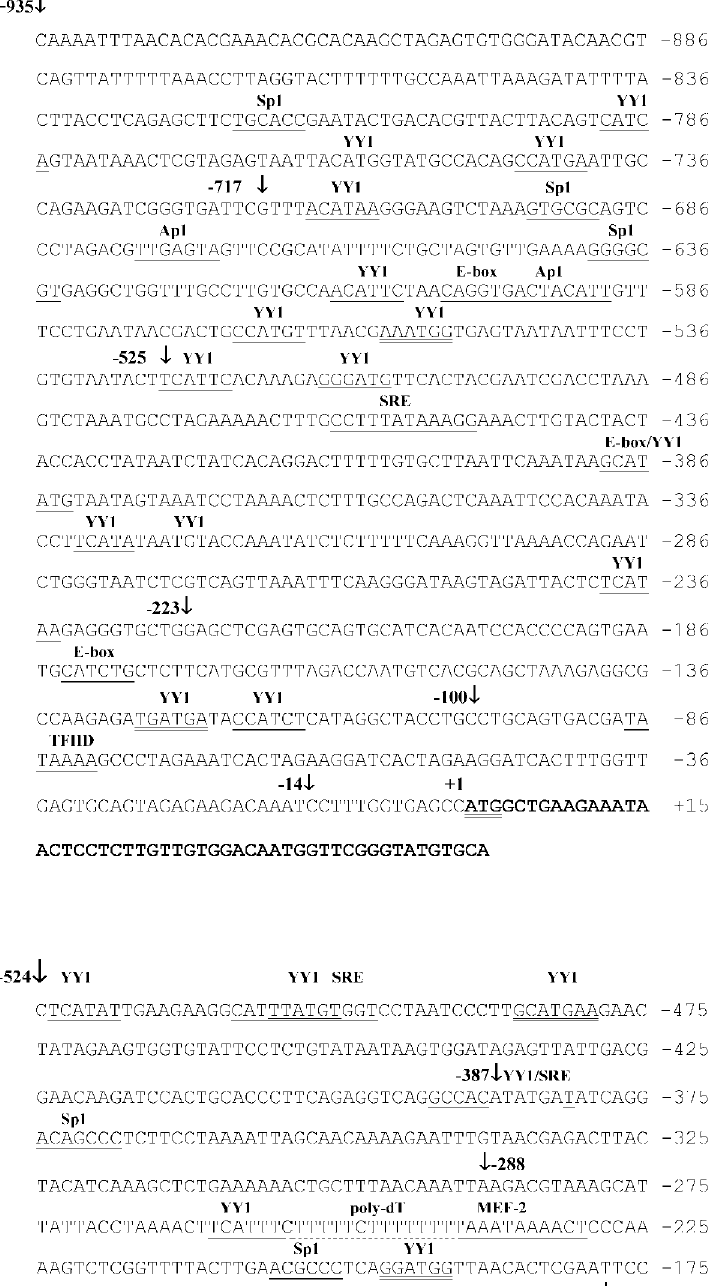
Figure 1 - Nucleotide sequence of the E. granulosus Egact I (A) and Egact II (B) 5-’flanking regions. Nucle- otides are numbered on the right in relation to the translation start codon (ATG), designated as +1 for the A of the Met initiation codon. Putative transcription factor binding sites are underlined. Putative binding sites for YY1 in the complementary strand are double underlined. The poly (dT) tract is underlined with a broken line. The coding sequence is shown in bold face type and the ATG translation start codon is double underlined. Arrows above the sequence denote 5' de- letion end points and arrows below the sequence de- note 3' end